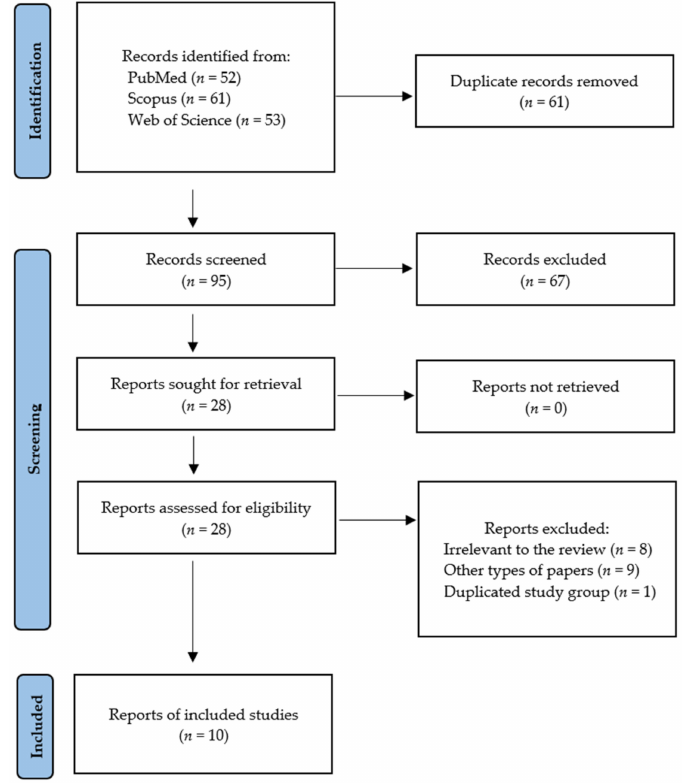
Figure 1. PRISMA flow diagram presenting search